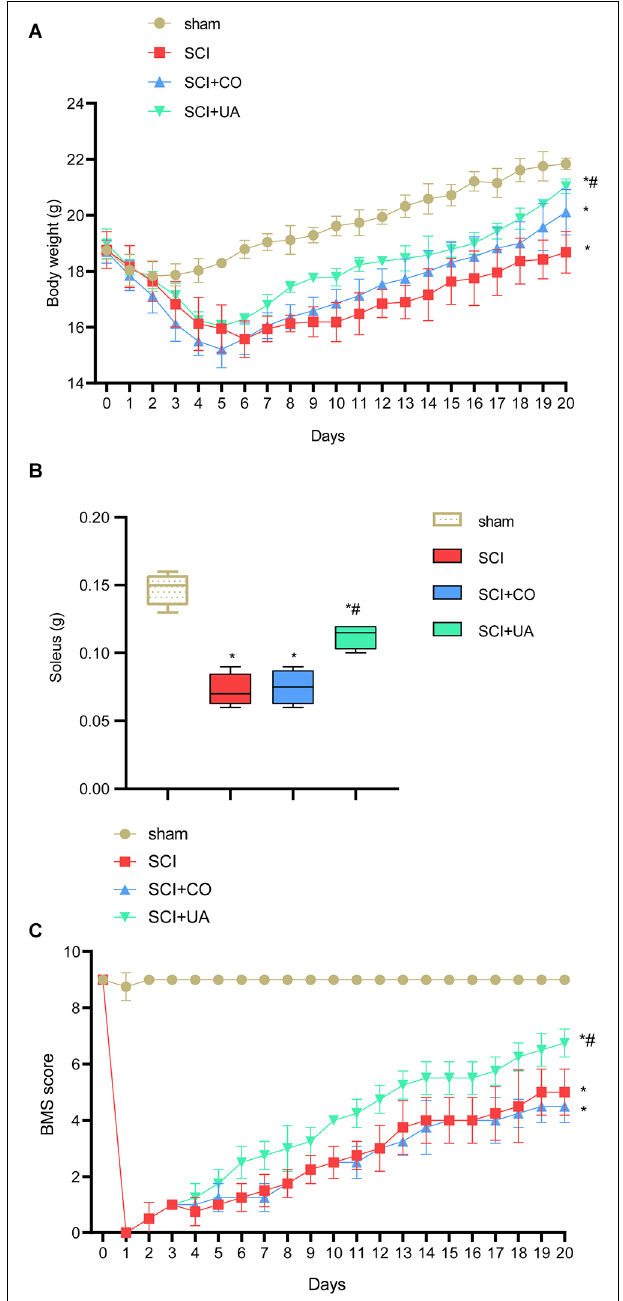
FIGURE 1 | UA improved the motor function of SCI mice. (A) The bodyweight of mice at different times. (B) The weight of mice soleus. (C) BMS score was applied to monitor the motor function recovery. Data were expressed as mean ± standard deviation; each experiment was repeated at least three times; n = 3; differences among multiple groups were evaluated by one-way ANOVA followed by a Tukey multiple comparisons post-test. * P < 0.05 vs. the sham group; # P < 0.05 vs. the SCI+CO group.